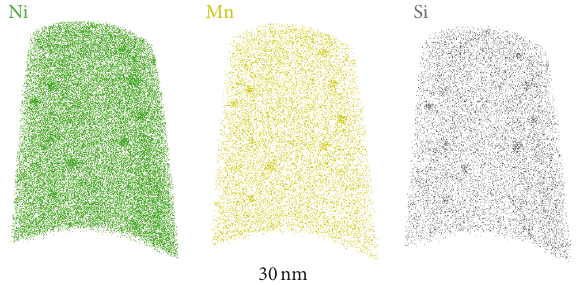
Figure 8: 3D mapping of the elements forming radiation-induced precipitates in 15Kh2NMFAA steel irradiated at 300 ∘ C obtained by